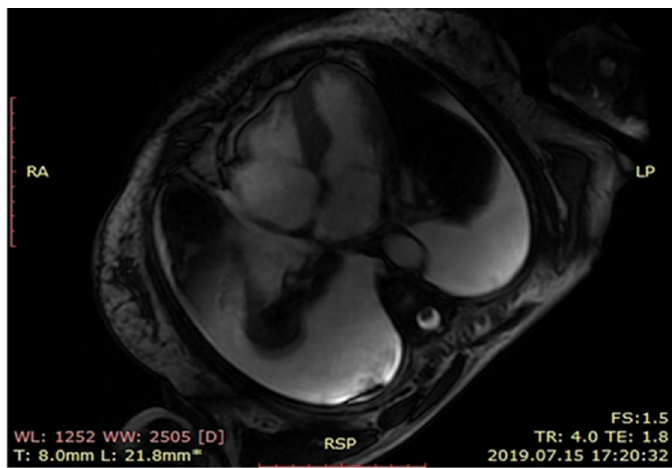
Figure 2. MRI scan showing left ventricle hypertrophy.